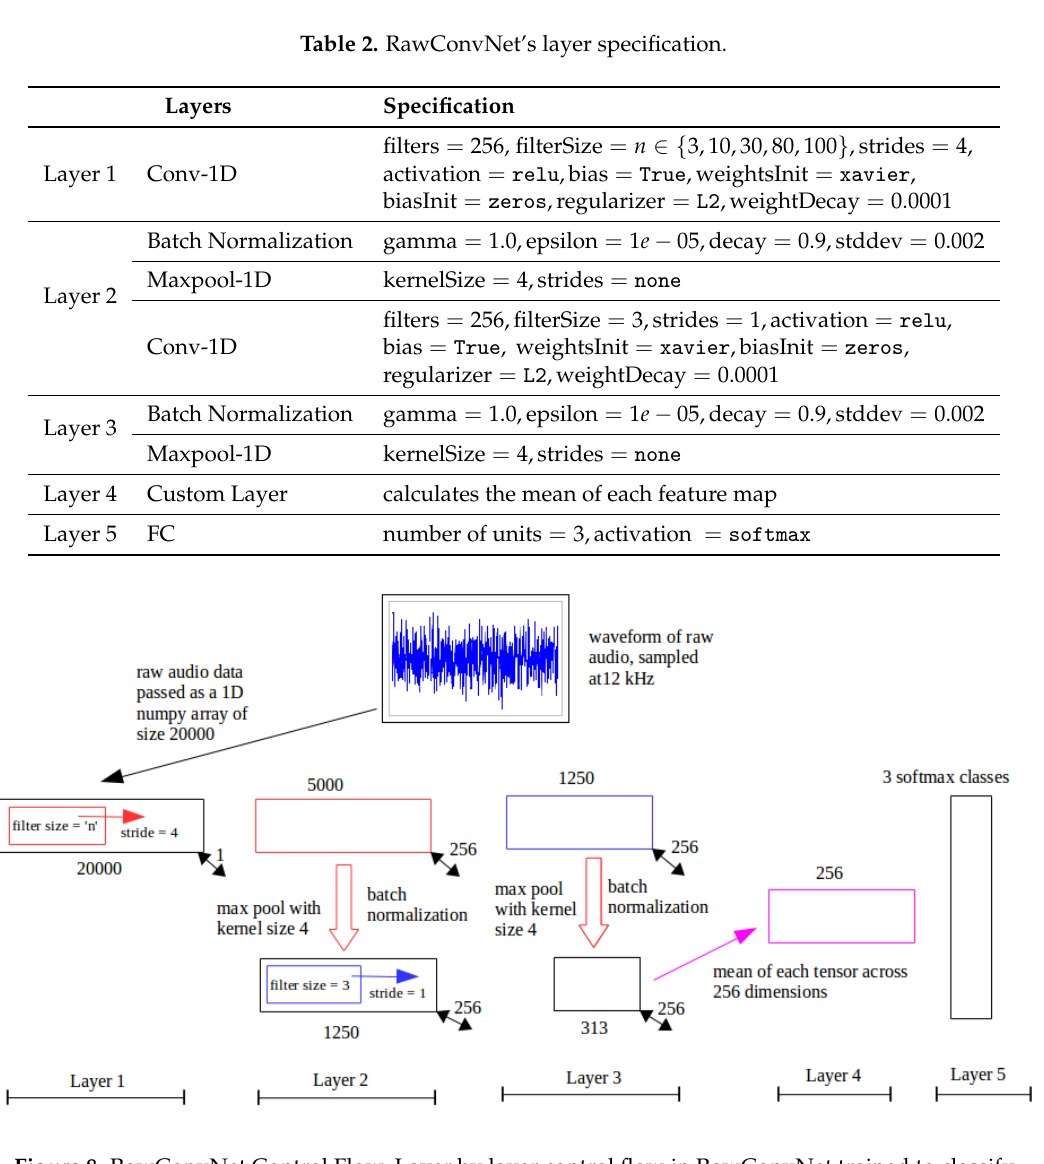
Figure 8. RawConvNet Control Flow. Layer by layer control flow in RawConvNet trained to classify raw audio samples; the numbers below each box at the corners of each rectangle represent the corresponding dimensions; all filters and feature maps are rectangular in shape with a breadth of one